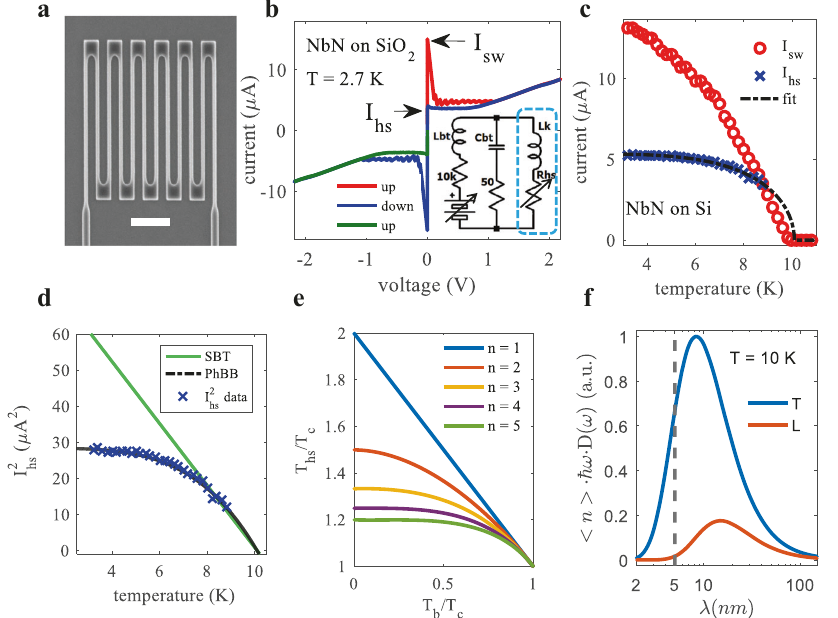
Fig.1|Measurementsandmodelingof I hs ( T b ).a Scanningelectronmicrographof adevicemeasuredforthiswork.Scalebaris1 µ m. b TypicalhystereticIVcurveofa superconducting NbN nanowire with the switching ( I sw ) and hotspot ( I hs ) currents labeled. The measurement circuit is inset. Only the nanowire was cooled (blue (cid:1) (cid:3) (cid:1) (cid:3) and I hs T b forNbN on Sidevice.Fitting of I hs is shownand dashed box). c I sw T b (cid:1) (cid:3) data and fi t from c was squared and discussed below. d The I hs T b